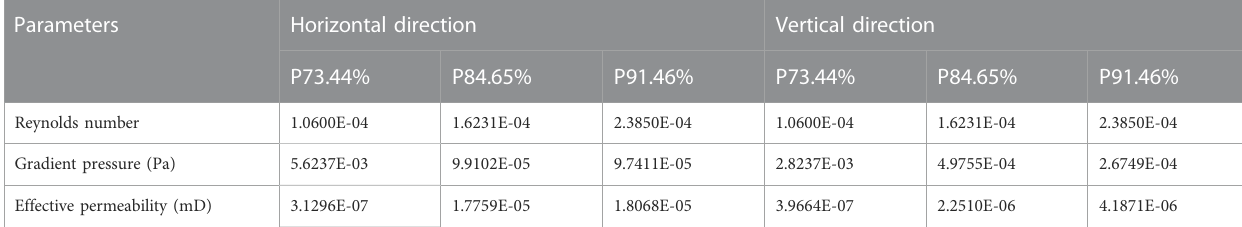
TABLE 2 Results of CFD analysis.